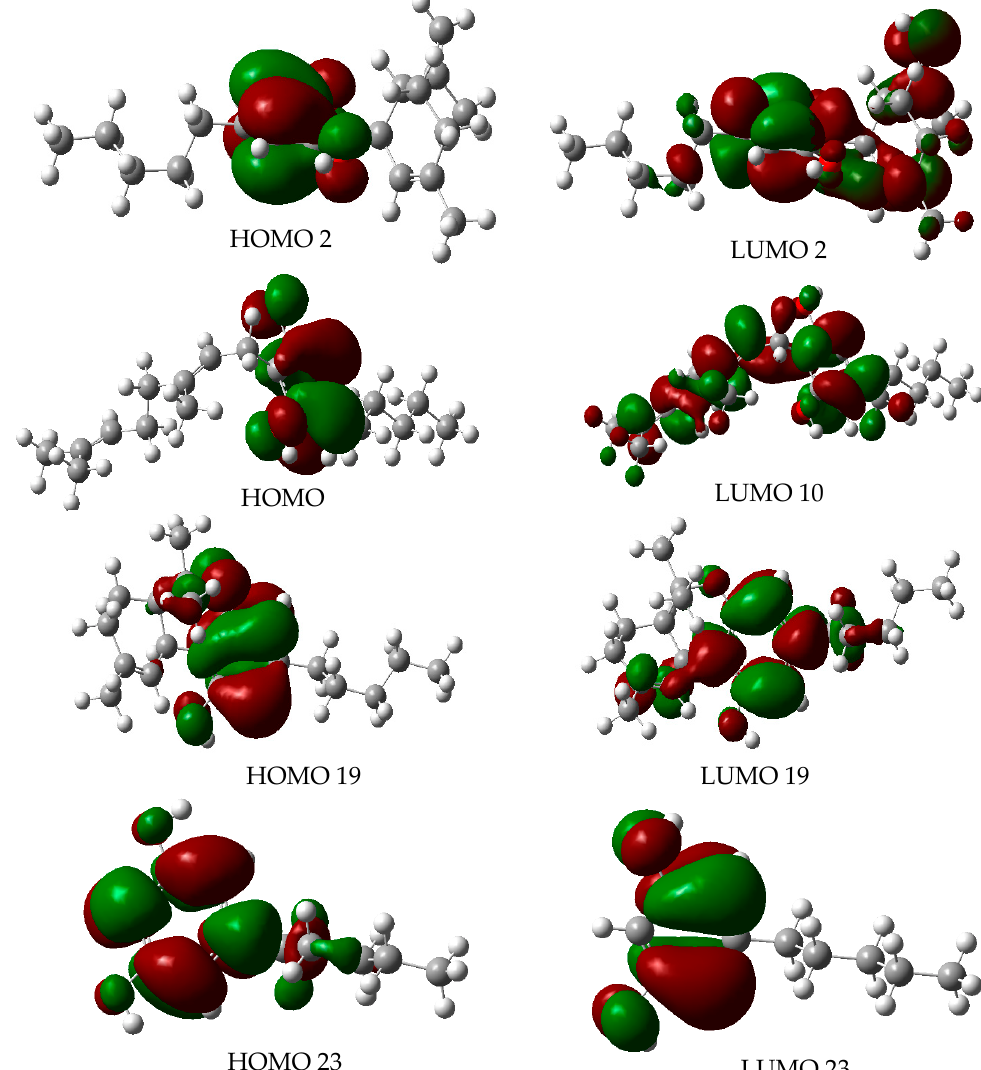
Figure 3. Frontier orbitals (highest occupied molecular orbital (HOMO) and lowest unoccupied molecular orbital (LUMO)) for both active and inactive cannabinoids.